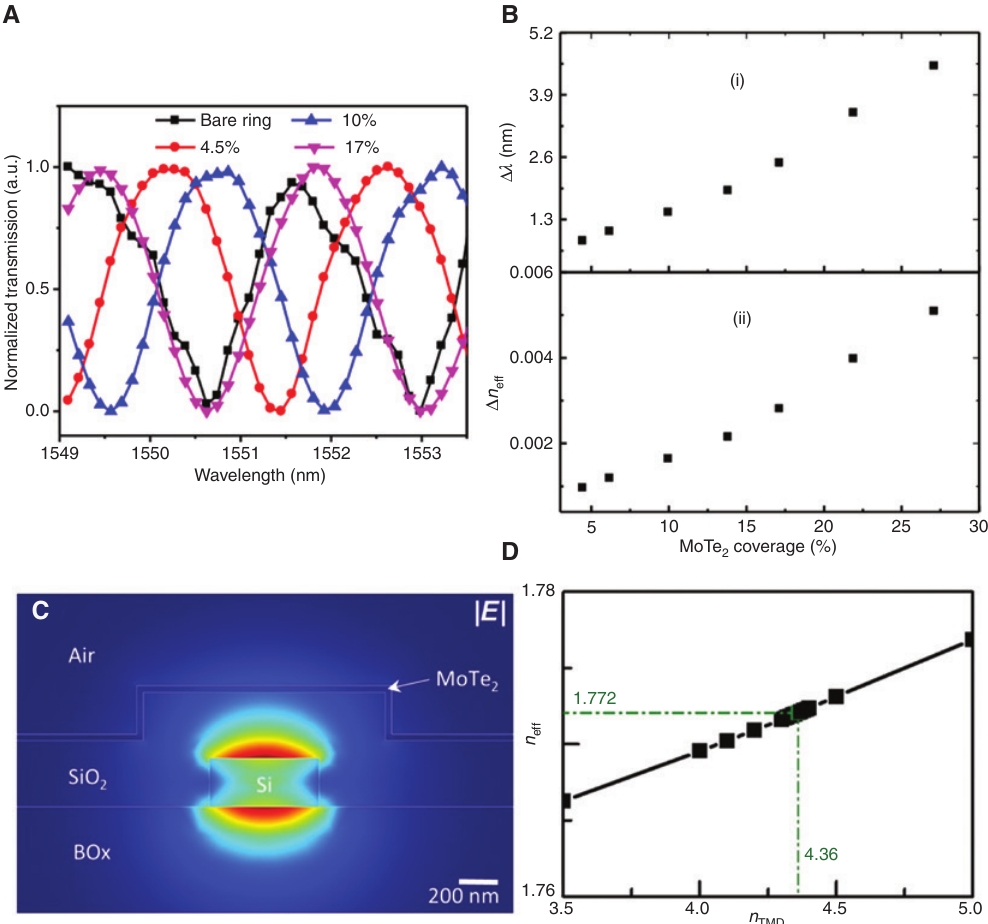
Figure 4: Ring resonator as refractive index